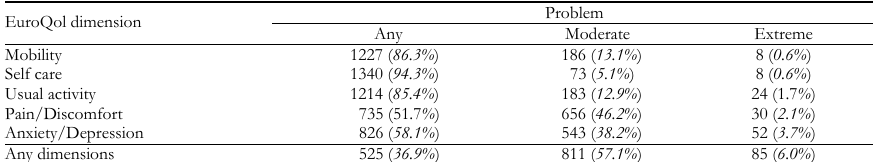
Rates of reported problem on EQ-5D